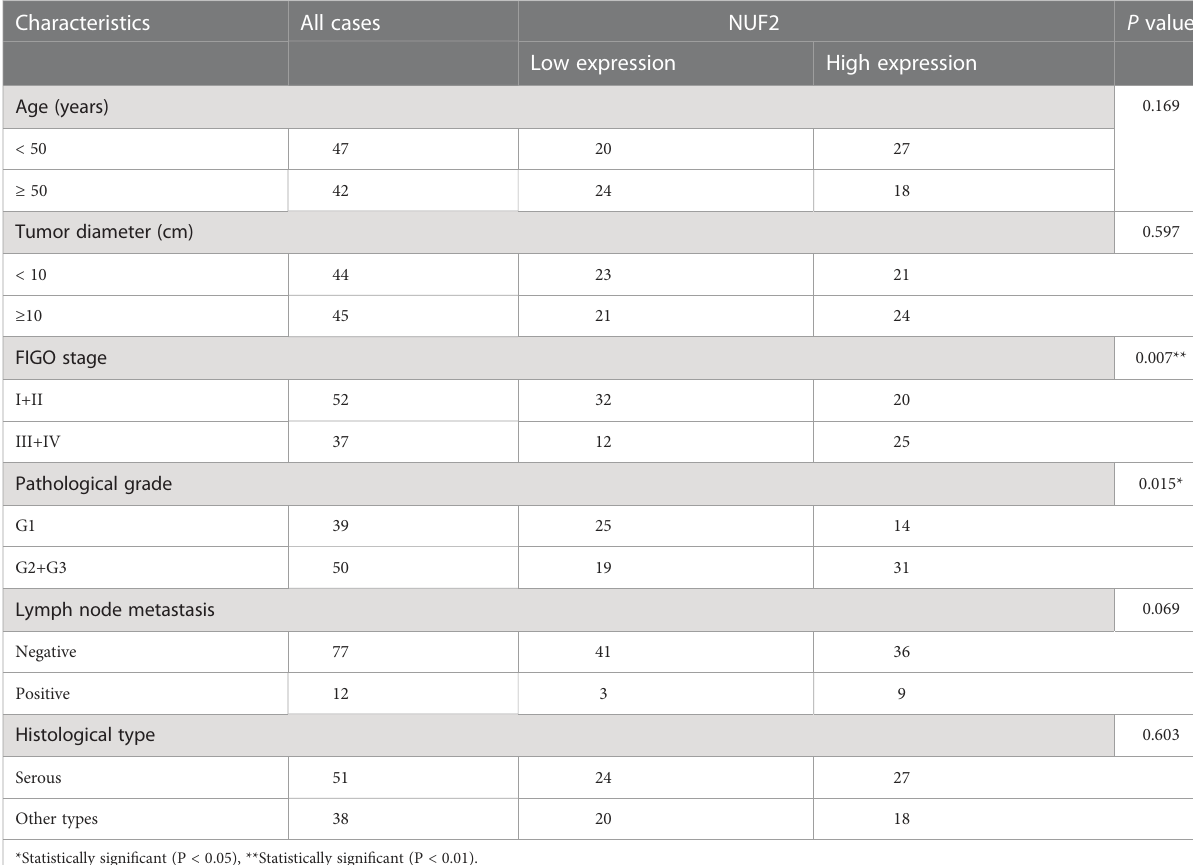
TABLE 1 Relationship between NUF2 expression and clinicopathological characteristics in 89 patients with EOC.